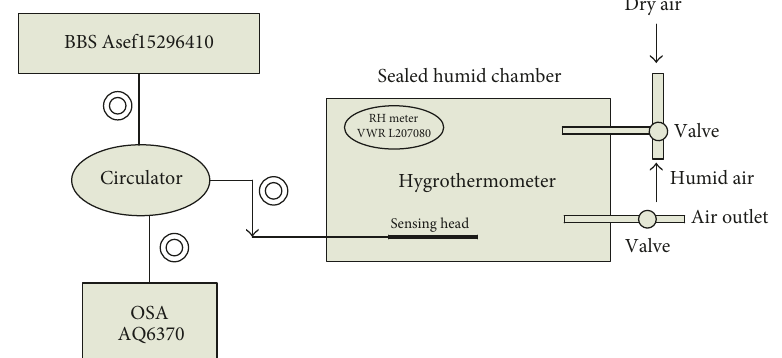
Figure 4: Experimental setup for the proposed humidity sensor.